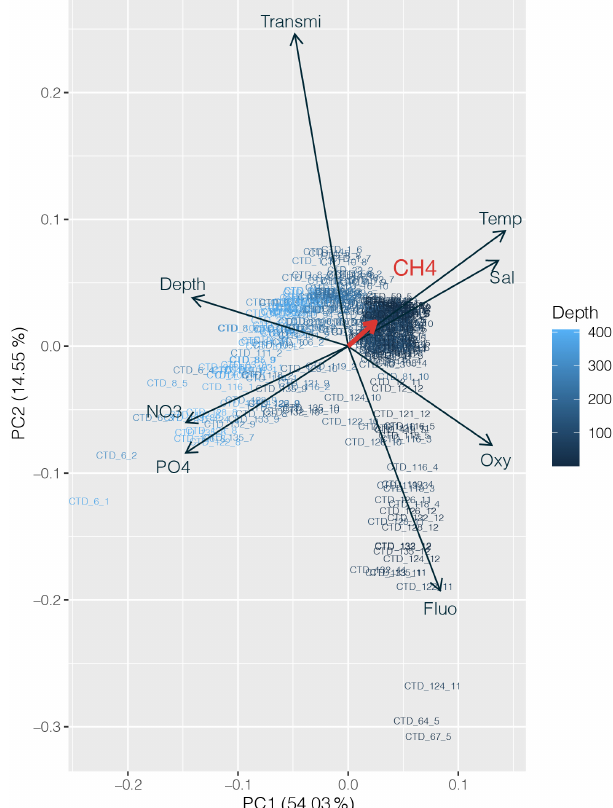
Figure 4. Principal component analysis (PCA) between dissolved CH 4 concentrations (in red) and other physicochemical parameters (nutrients, depth, fluorescence, temperature, salinity and turbidity). Numbers on the x and y axes indicate the factor loadings of each variable of each principal component (PC). The percentages show the explained variability in the dataset by each